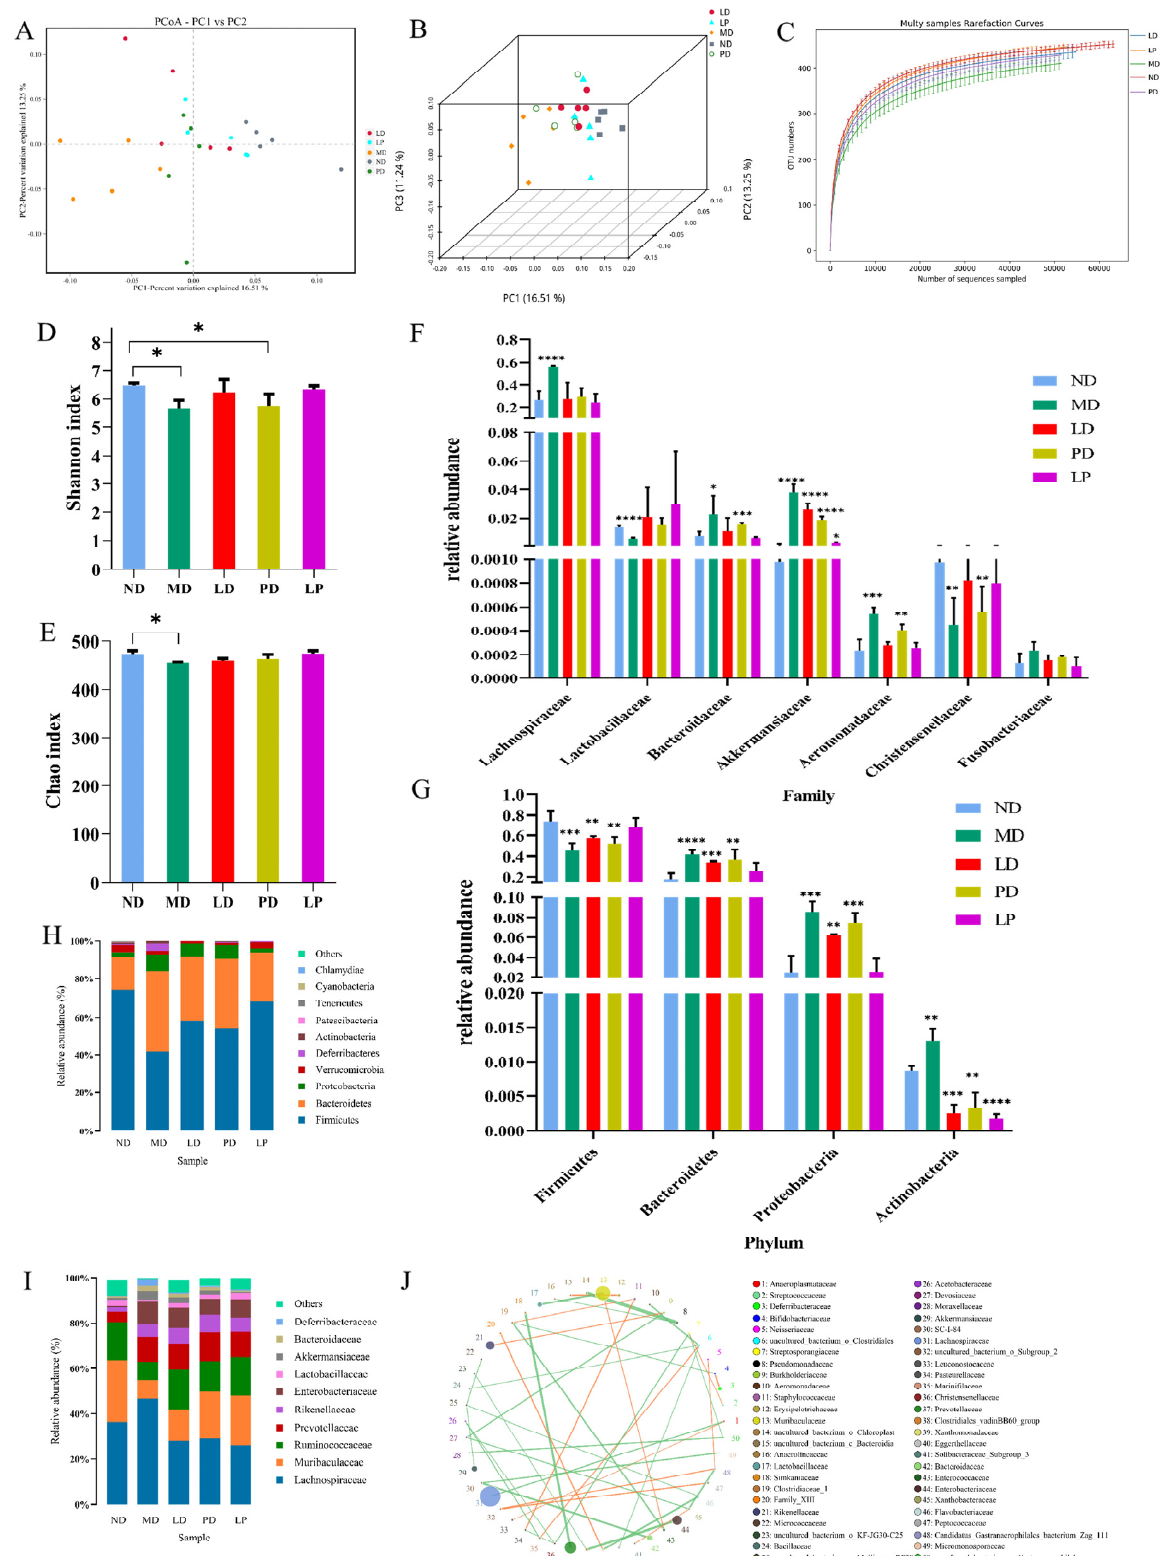
Figure 4. Synbiotics alleviated intestinal flora disturbance in CCl 4 -induced ALI mice. ( A ) PCoA analysis chart, PC1 vs. PC2, “the dots represent each sample; the horizontal and vertical coordinates are the two characteristic values that cause the largest differences between the samples” ( n = 5). ( B ) Three-dimensional PCoA analysis chart, PC1 vs. PC2 vs.